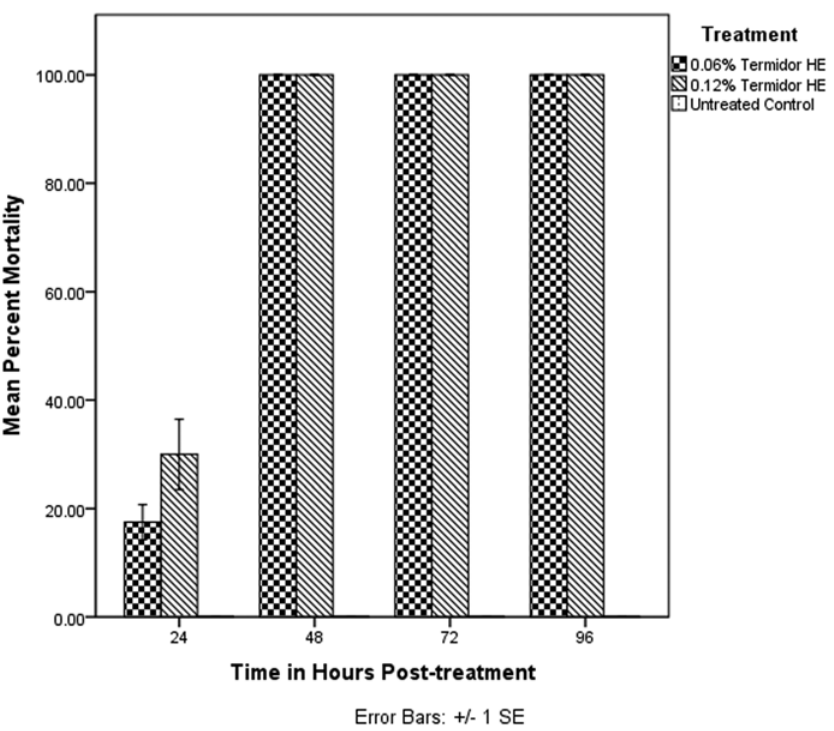
Fig. 3 . Mean percent mortality of Reticulitermes flavipes through time when exposed to soils treated with Termidor ®